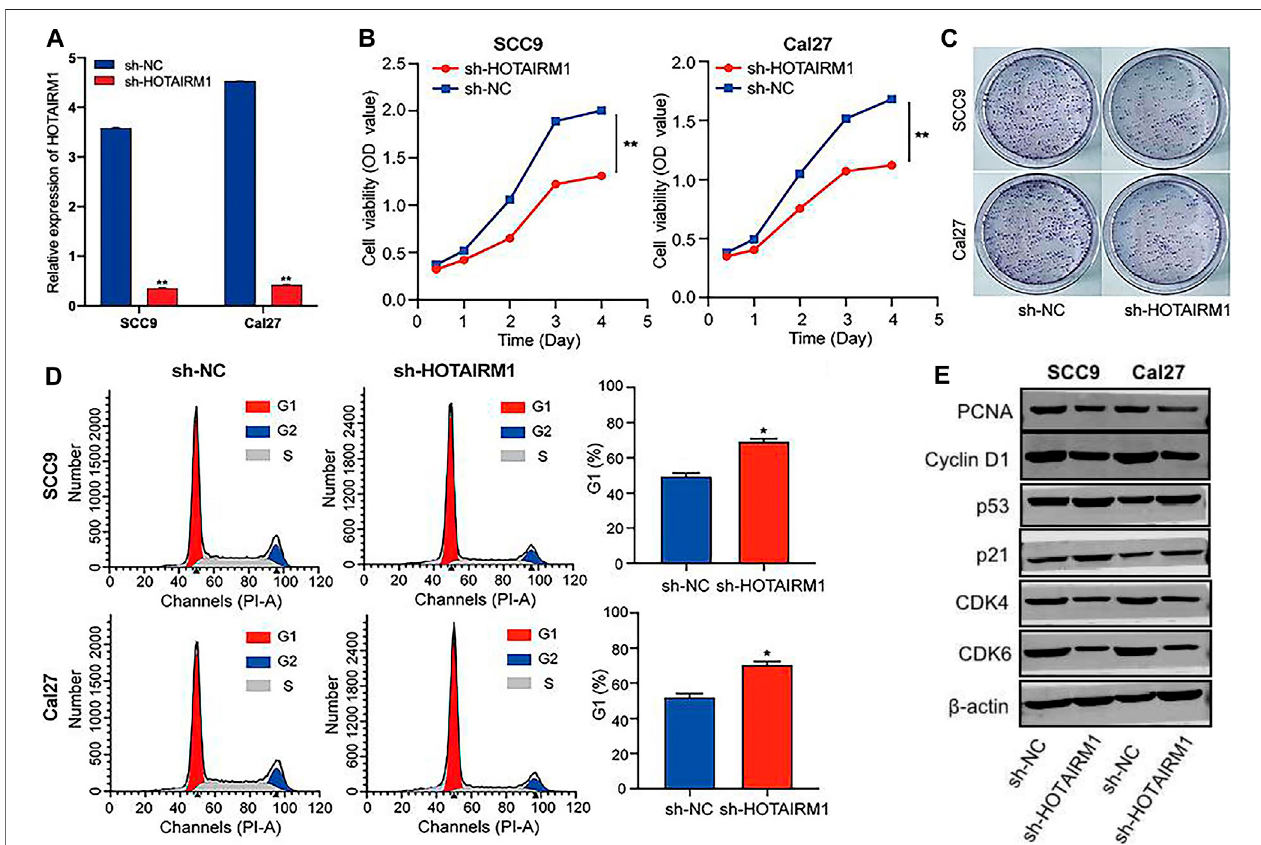
FIGURE6| Invitro knockdown ofHOTAIRM1restrainedcellproliferationandregulatedthecellcycleinOSCCcells. (A) Knockdownef fi ciencybysh-HOTAIRM1in SCC9andCal27cellswerevalidatedbyqRT-PCR. (B) KnockdownofHOTAIRM1expressioninOSCCcellssuppressedcellgrowthmeasuredviatheCCK-8assay. (C) Colony formation assays evaluated the in fl uence of HOTAIRM1 knockdown on cell proliferation of OSCC cells. (D) Flow cytometry was used to evaluate the impact on cell cycle distribution by knockdown of HOTAIRM1 expression in OSCC cells lines. (E) Western blotting showing changes in key biomolecules related to cell proliferation and cell cycle regulation, including PCNA, CyclinD1, p53, p21, CDK4, and CDK6. * p < 0.05, ** p < 0.01.